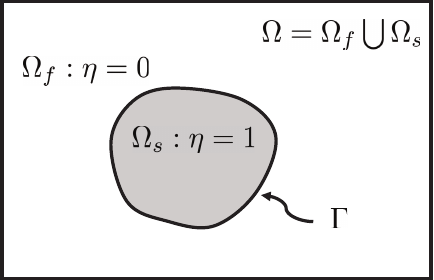
Figure 1. A schematic diagram of solid and fluid distinguished by a volume of solid (VOS) function η